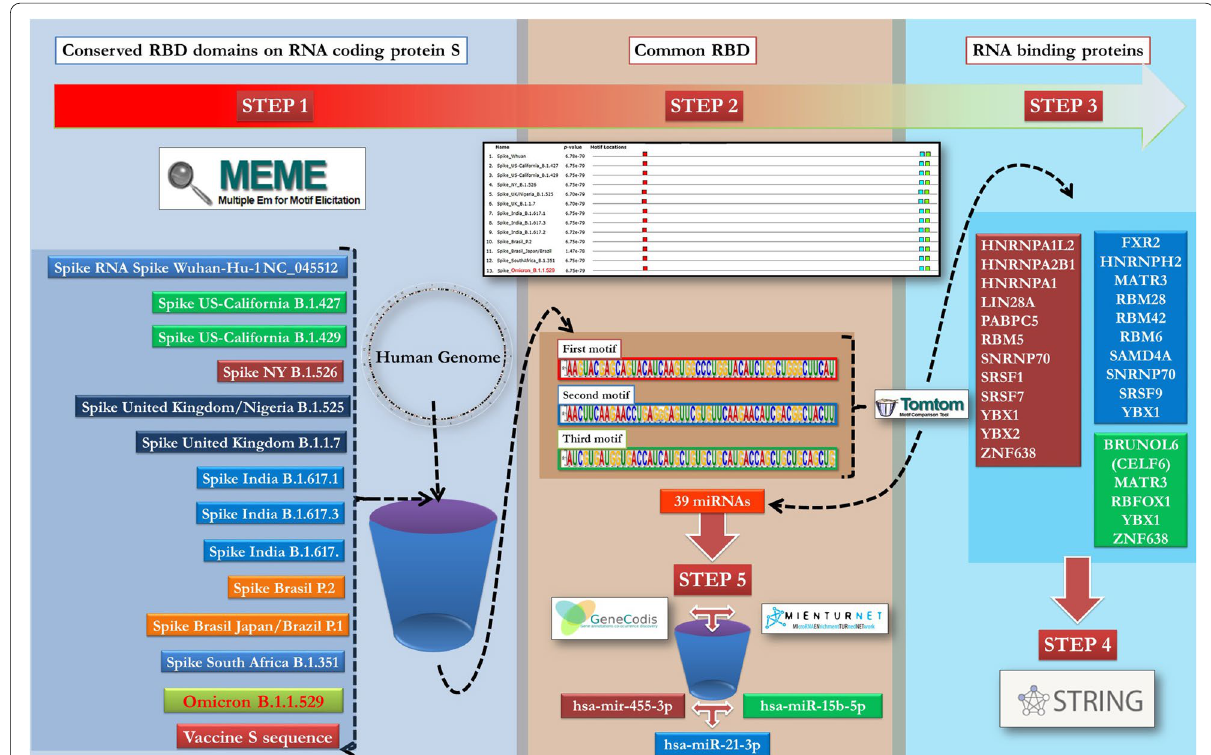
Fig. 1 The analysis pipeline’s main steps and bioinformatics tools. There are five steps in the pipeline: Step 1: Identify conserved motifs by aligning and analyzing all RNA coding spike protein and vaccine sequences. MEME output is the second step. The analysis reveals the presence of three distinct motifs across the entire S sequence (box red, light blue, and green). The identified nucleotide sequences are listed below the alignment. Step 3: The sequences were fed into TomTom, which compared the newly discovered motifs to the database of Homo sapiens RNA-binding motifs. For all motif queries, a list of Human RNA-binding proteins was obtained (box red, light blue, and green). Step 4: STRING is used to look for RBP protein interactions in metabolic pathways. Step 5: The same motifs are used as a query for TomTom to find mature microRNAs within conserved sequences using the micro-RNA database. The list of 39 miRNA was obtained and used in GeneCodis4 and MIENTURNET as a query. The results of the two software programs are combined to infer possible shreds of evidence of significant concurrent annotations (computational or experimental), with those that are significantly enriched being evaluated